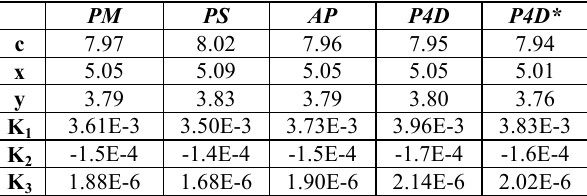
Table 3. Calibration results for the